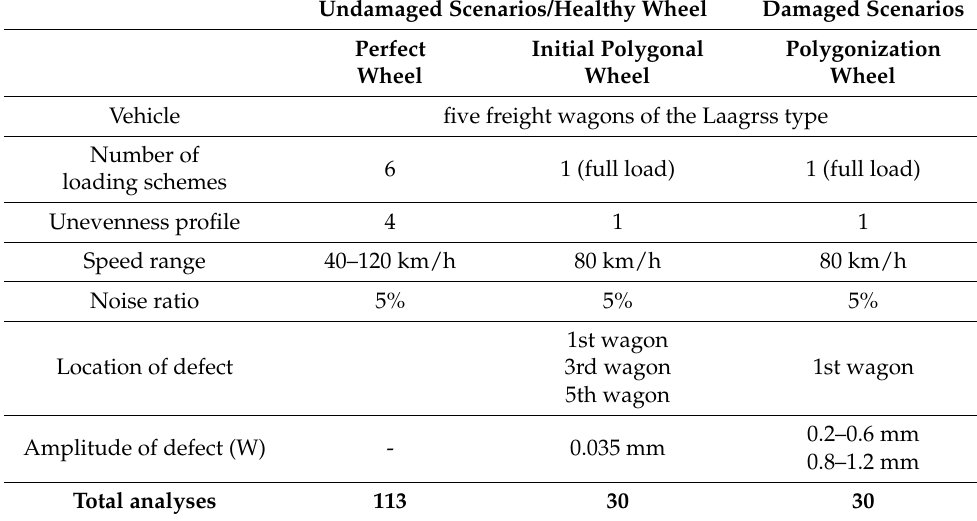
Table 3. Damaged and undamaged